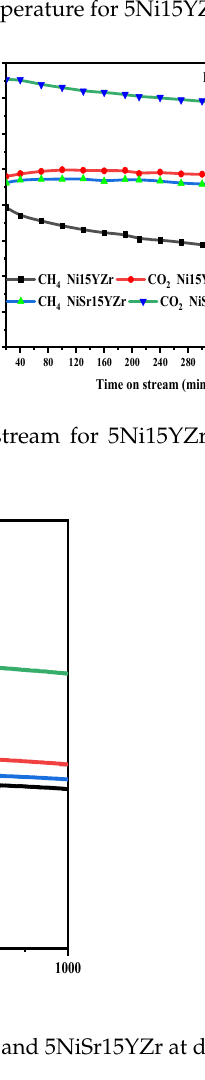
rate causes a longer residence time of the reactants on the catalyst. Figure 13 also shows